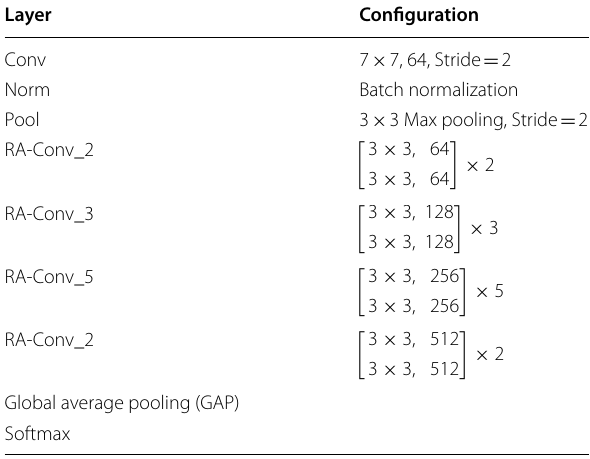
Table 1 Network structure of the proposed CNN-based classification model